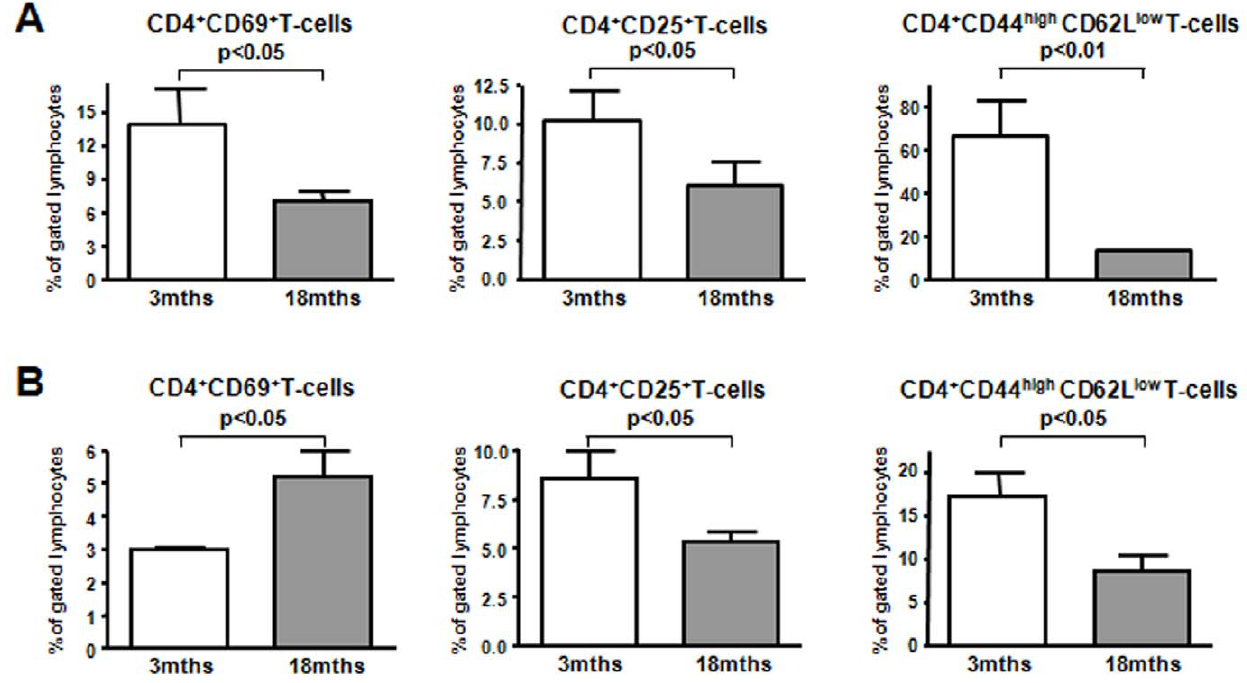
Figure 8. Reduced proliferation of old alloreactive effector/memory CD4 + T-cells. Old alloreactive effector/memory CD4 + T-cells proliferate less in response to antigen. Following adoptive transfer of young or old 2 6 10 6 transgenic CD4 + ABM T-cells nude B6 mice were engrafted with two bm12 skin transplants. One week later spleen ( A ) and dLN ( B ) were retrieved, leukocytes were stained for CD4, V a 2 and V b 8 expression and the expression of different cell surface markers (n=4). Relative numbers of CD69 + and CD25 + CD4 + T-cells were reduced in recipients spleens after transfer of old alloreactive T-cells indicating an impaired activation and proliferation. Similarly, alloreactive effector/memory CD4 + T-cells were significantly reduced 7 days after restimulation in vivo ( A ). In contrast, enhanced early activation (CD69 + ) of old tg CD4 + T-cells in draining lymph nodes did not lead to a stronger expansion of effector/memory T-cells most likely due to an impaired IL-2 production ( B ).